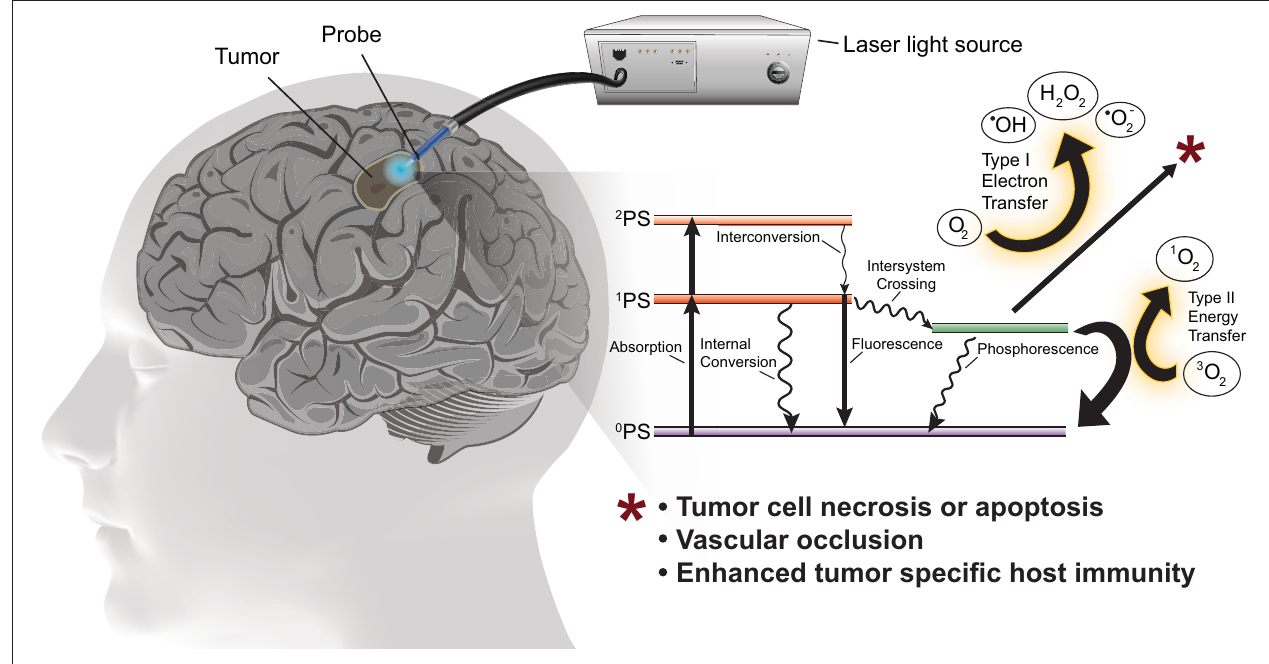
FIGURE 1 | Schematic of PDT for the treatment of glioblastoma with simplified energy diagram of the oxygen dependent photodynamic response. The photosensitizer in the ground state ( 0 PS) is excited to one of two states by the appropriate wavelength and power photostimulation, the first excited singlet state ( 1 PS) or the second excited singlet state ( 2 PS). The 1 PS may then convert to the excited triplet state ( 3 PS) via intersystem crossing. In the presence of molecular oxygen, the 3 PS may undergo Type I or Type II redox reactions producing reactive oxygen species which cause tumor cell